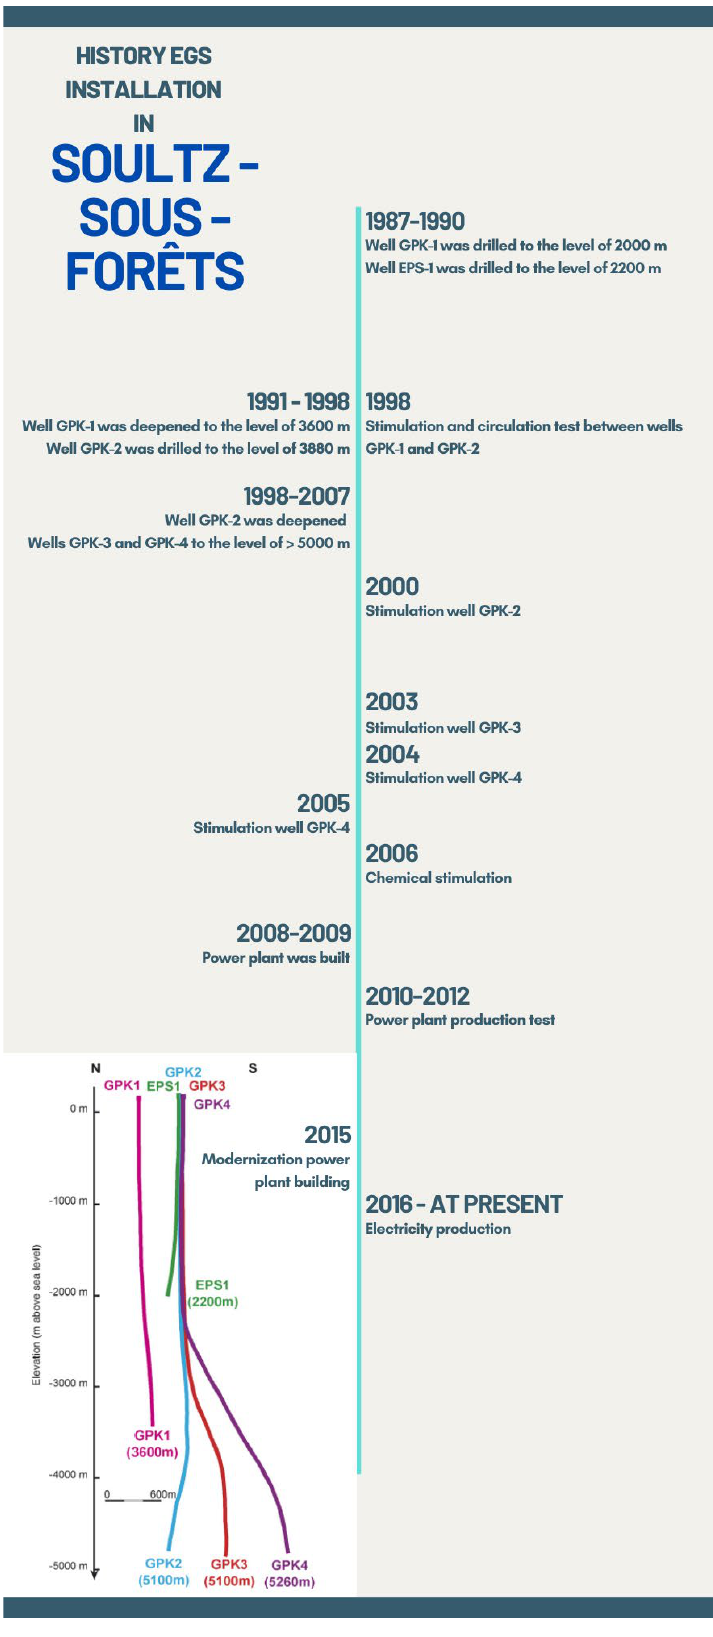
Figure 4. Short story EGS Power Plant in Soultz-Sous-Forêts (based on [31]).